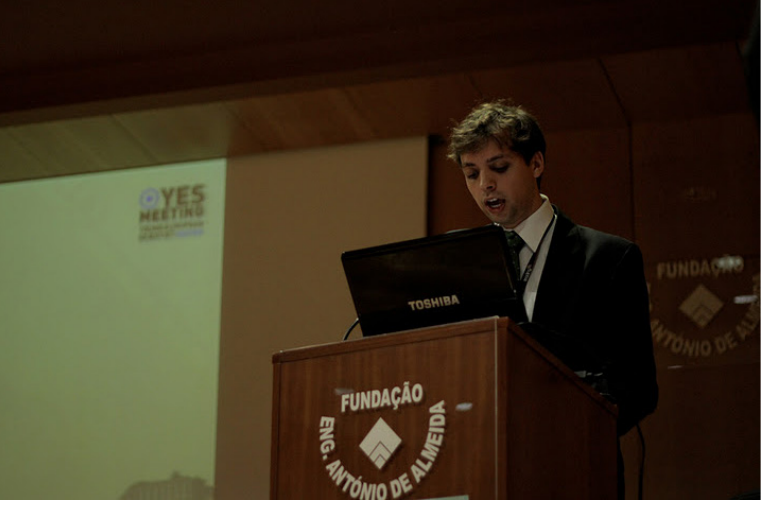
Figure 1. Delfim Duarte, President of the 6th Young European Scientist Meeting 2011 at Opening.